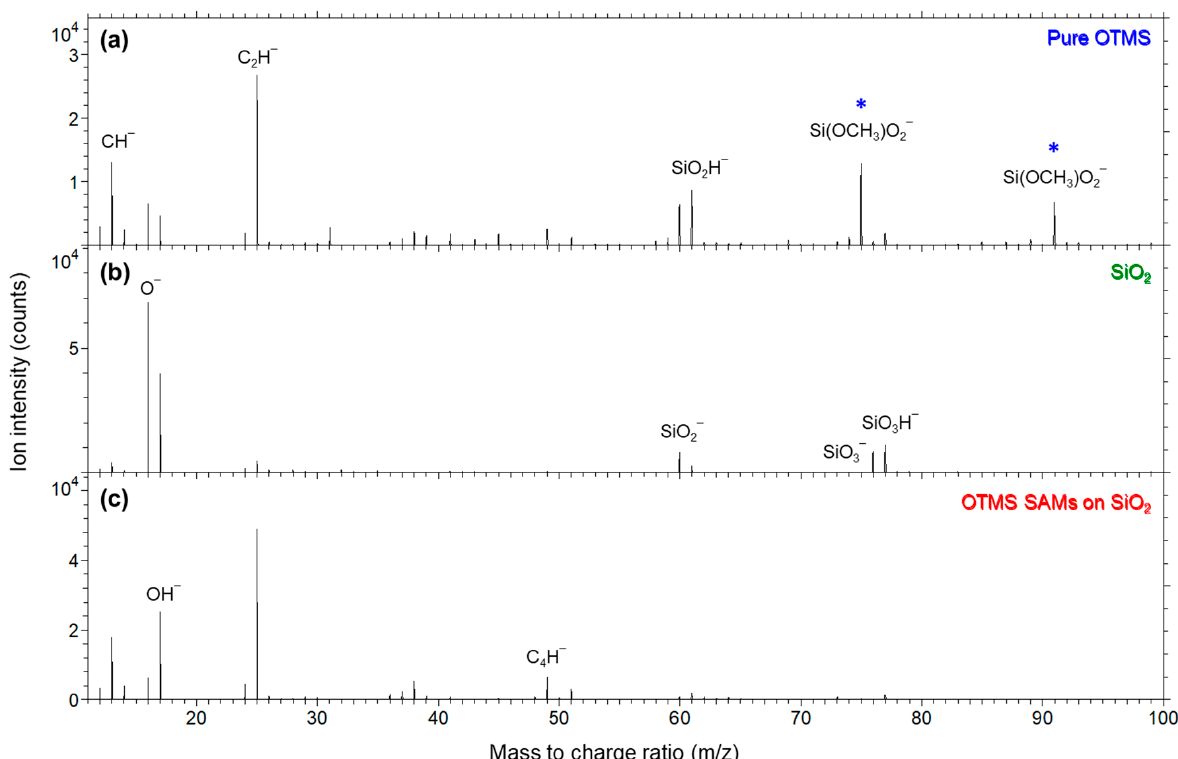
Figure 4. Negative secondary ion mass spectra ( m / z 11–100) for ( a ) pure OTMS molecules (placed on a polypropylene film); ( b ) a UV/ozone-treated SiO 2 substrate; ( c ) OTMS SAMs prepared on a UV/ozone-treated SiO 2 substrate. Ions indicated by a star (*) are associated with the OTMS headgroup, –Si(OCH 3 ) 3 .